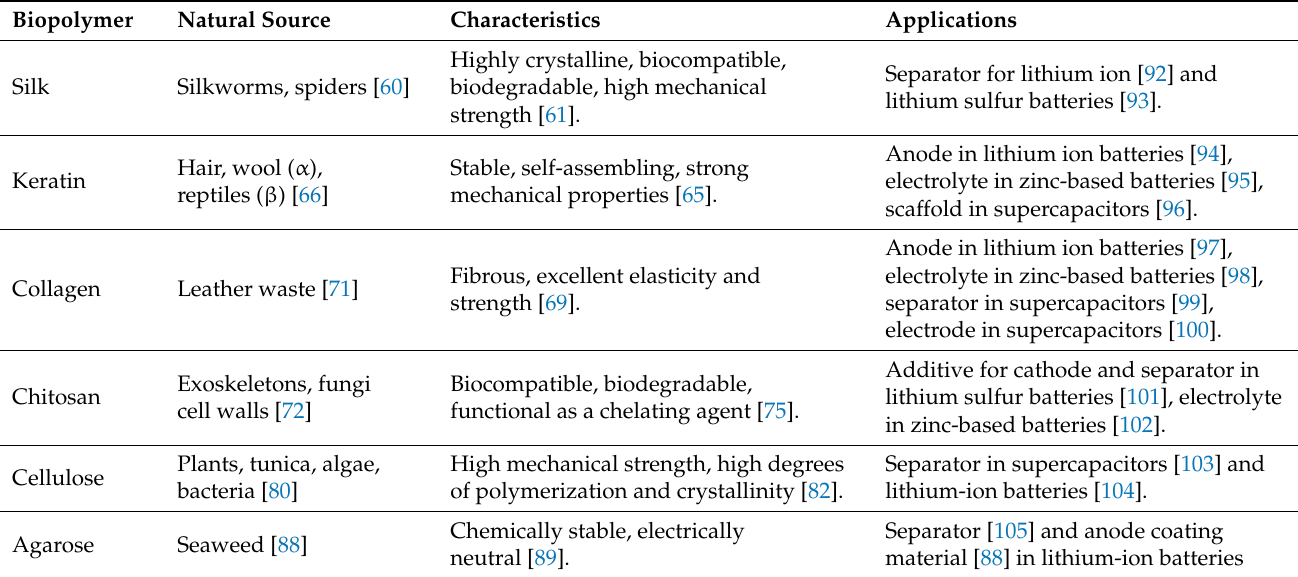
Table 1. Overview of natural biopolymers as energy storage